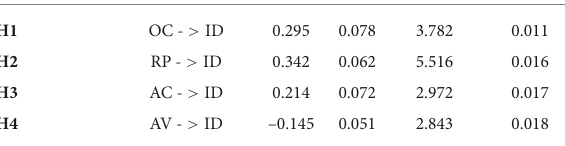
TABLE 4 Structural model assessment (direct effect results and decision).